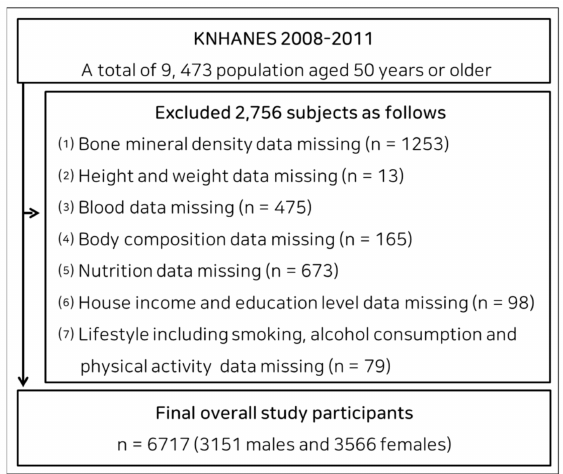
Figure 1. Flow chart of participants’